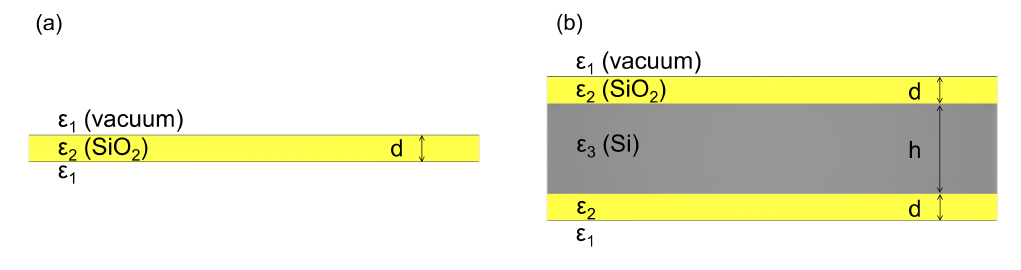
Figure 1. Scheme of ( a ) a single SiO 2 film and ( b ) a three-layer structure (SiO 2 /Si/SiO 2